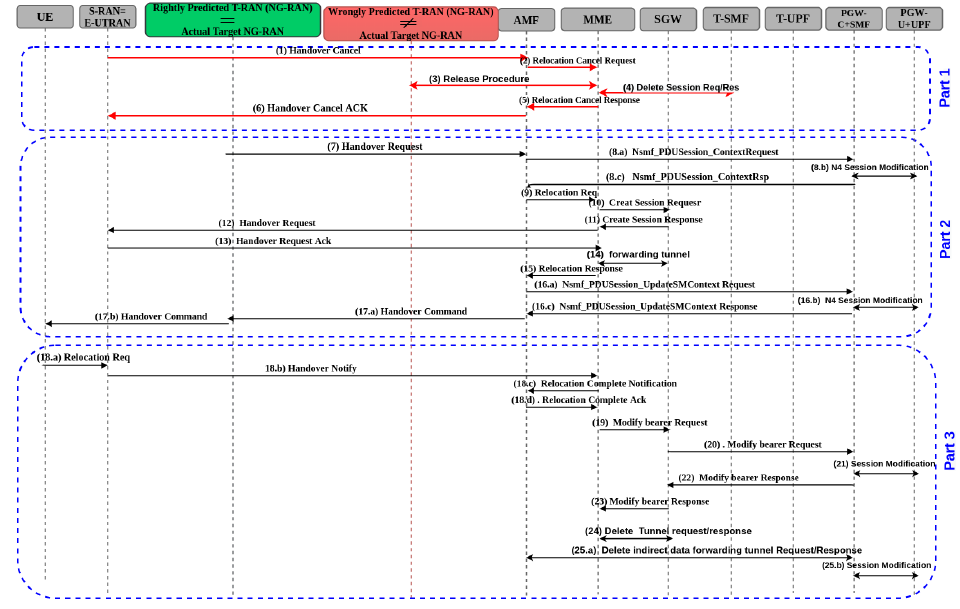
Figure 4. Inter-RAT handover signaling diagram (from 5G NGC to